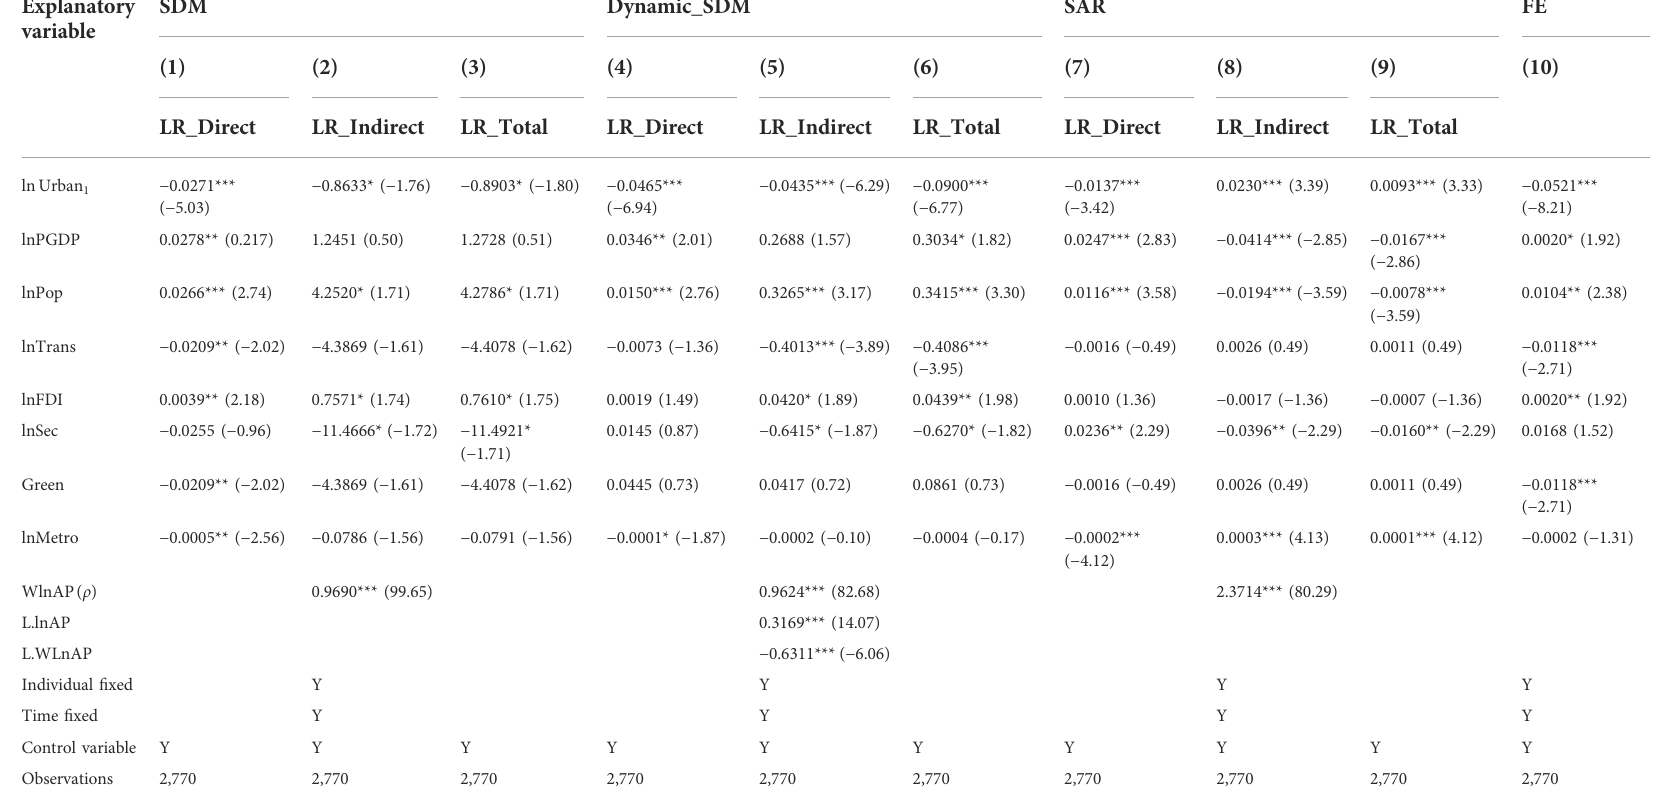
TABLE 4 Model estimation